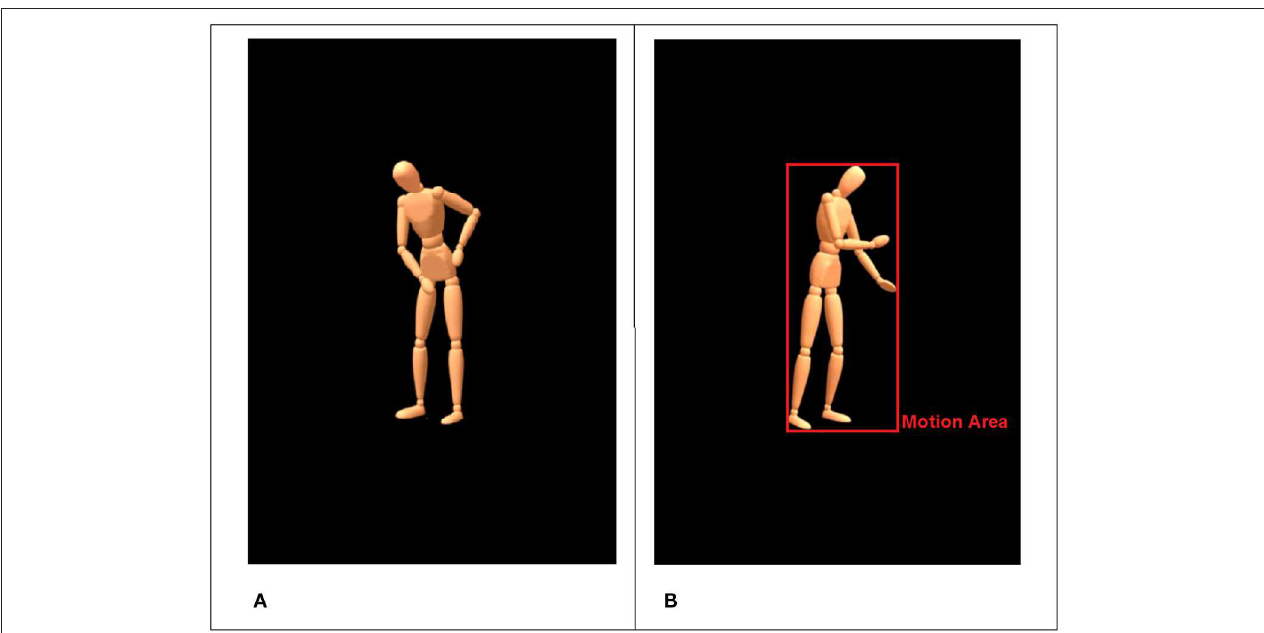
FIGURE 2 | Standardized virtual character with blank face used in the animations (A) . The red rectangle illustrates the detected motion area for the current frame (B)